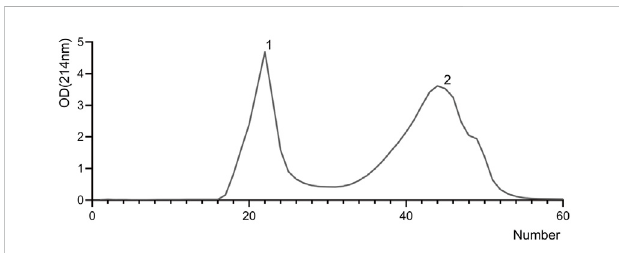
FIGURE 2 The fractions obtained by gel chromatography. Column chromatography: one tube per 3 ml was collected, 60 tubes in total.